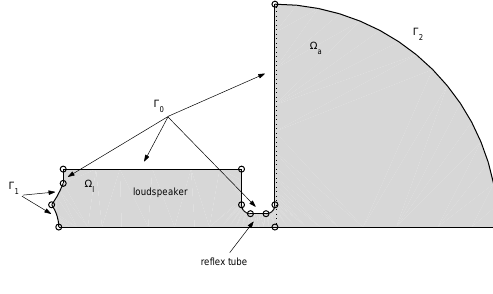
Figure 1. Computational